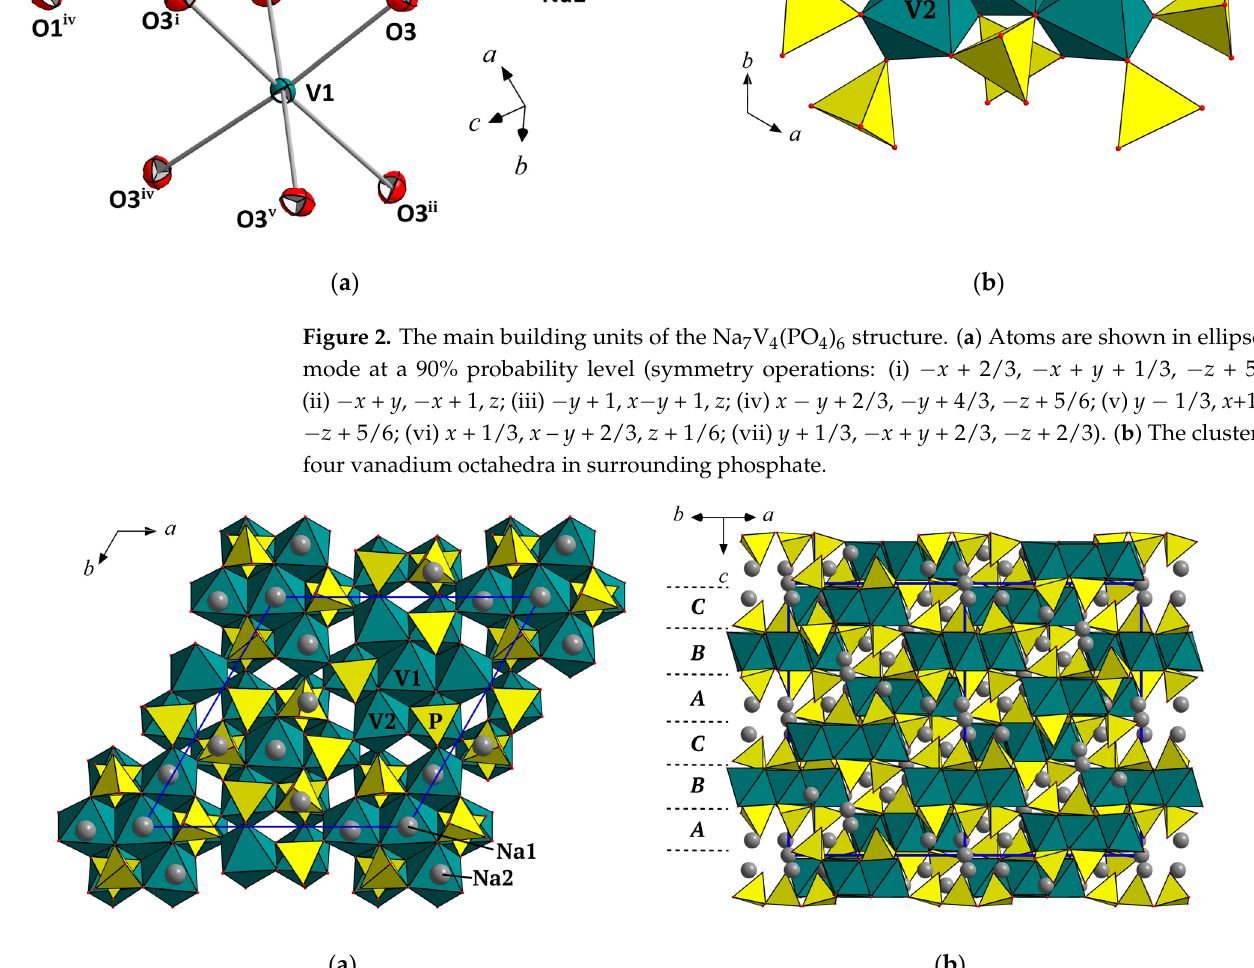
Figure 3. Crystal structure of the Na 7 V 4 (PO 4 ) 6 projected along ( a ) the [0001] and ( b ) the [11 2 0] direc-